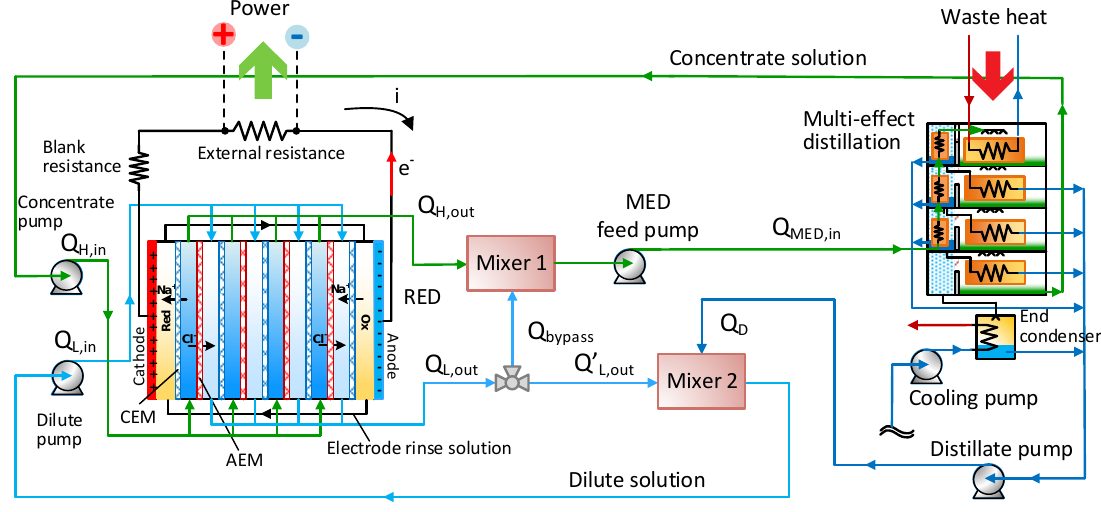
Figure 6. Process flow diagram of the RED-MED coupled system.